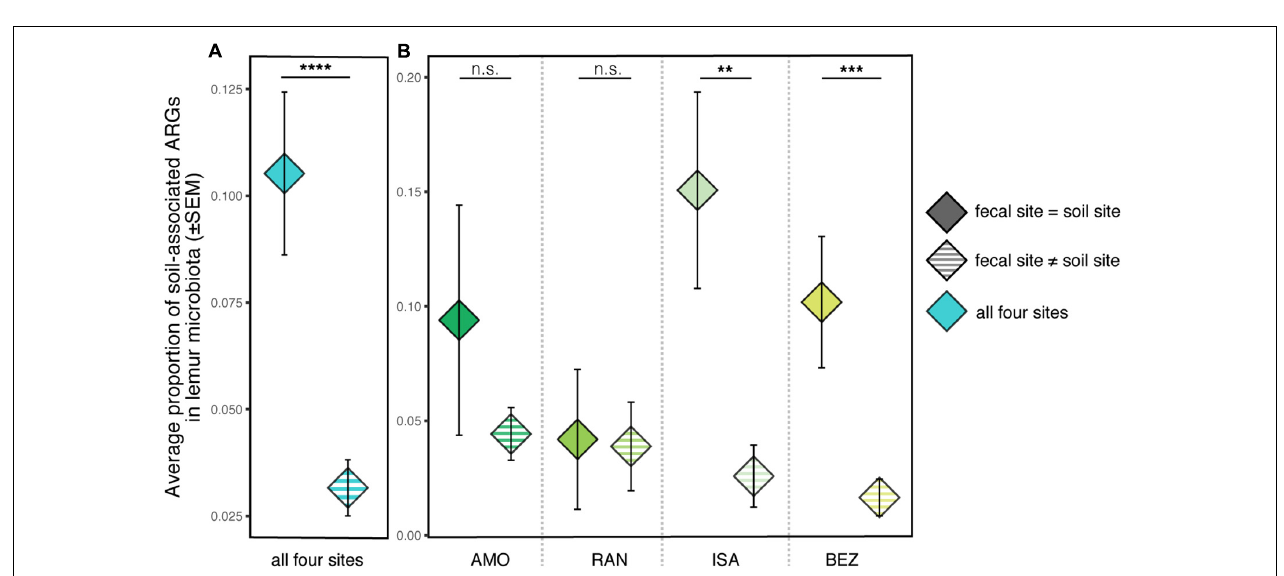
FIGURE 6 | Proportions of soil-associated ARGs present in ring-tailed lemur ( Lemur catta ) gut microbiota depending on whether the soil was from the same site as the lemur (fecal site = soil site; solid color) or from a different site (fecal site (cid:54)= soil site; striped). Data are shown (A) averaged across all four sites and (B) for each specific site. Kruskal–Wallis test with pairwise comparisons and Benjamini–Hochberg correction; ** p < 0.01, *** p < 0.001, **** p < 0.0001, n.s.,